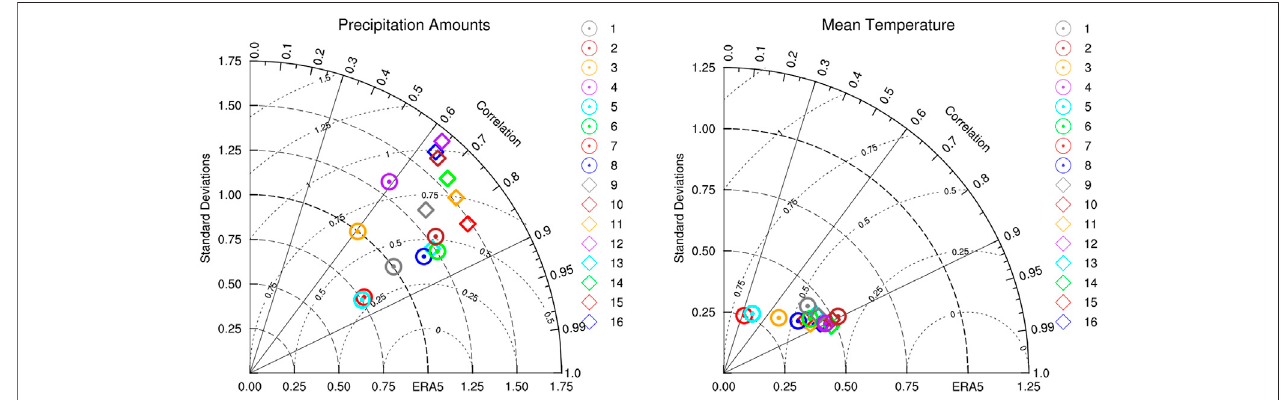
FIGURE 3 | Taylor diagrams, depicting the Pearson correlation coef fi cient (straight lines), the normalized standard deviation (dashed lines) and the root-mean- squareerror(RMSE) (dotted lines) betweensimulatedJJAprecipitation amounts (left) and JJAmeantemperature (right) ofthe16ensemble members and ERA5-Land reanalysis as reference data for the period 2006 – 2010.